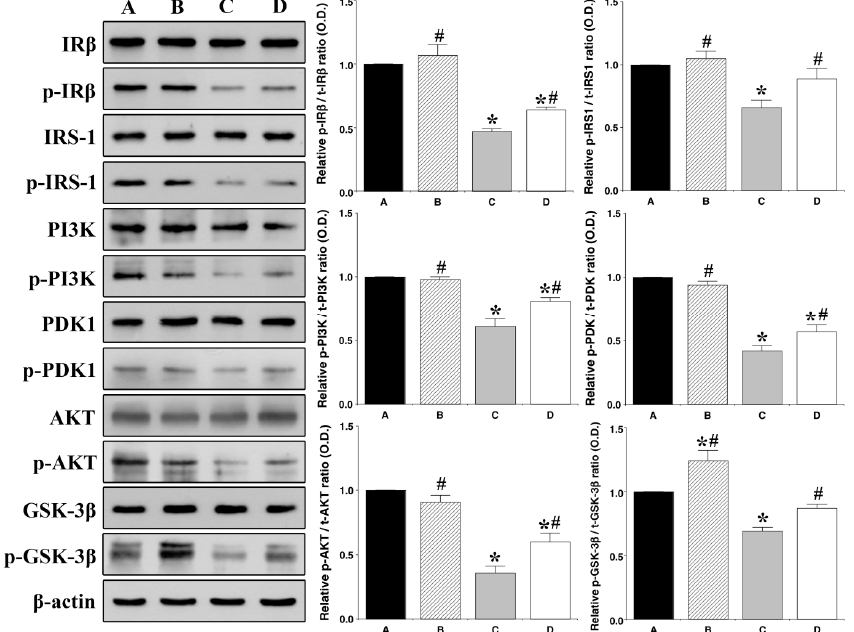
Figure 3. Effect of treadmill exercise on hippocampal insulin signaling. Control group A , control and exercise group B , high-fat diet group C , and high-fat diet and exercise group D . Data are expressed as the mean ± S.E.M. * Represents p < 0.05 as compared with the control (CON) group. # Represents p < 0.05 as compared with the high-fat diet (HFD) group.